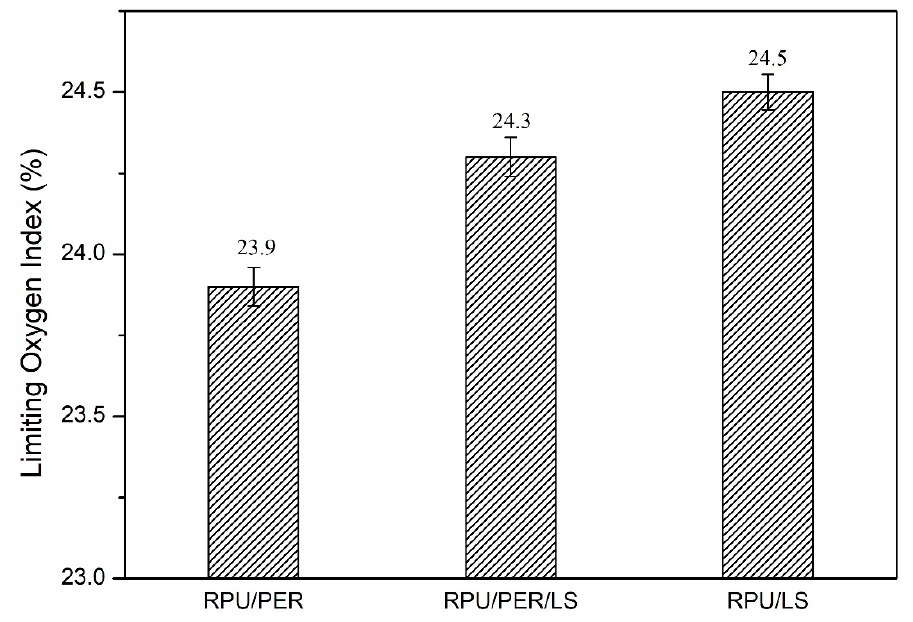
Figure 1. The effect of LS as a char forming agent on LOI.